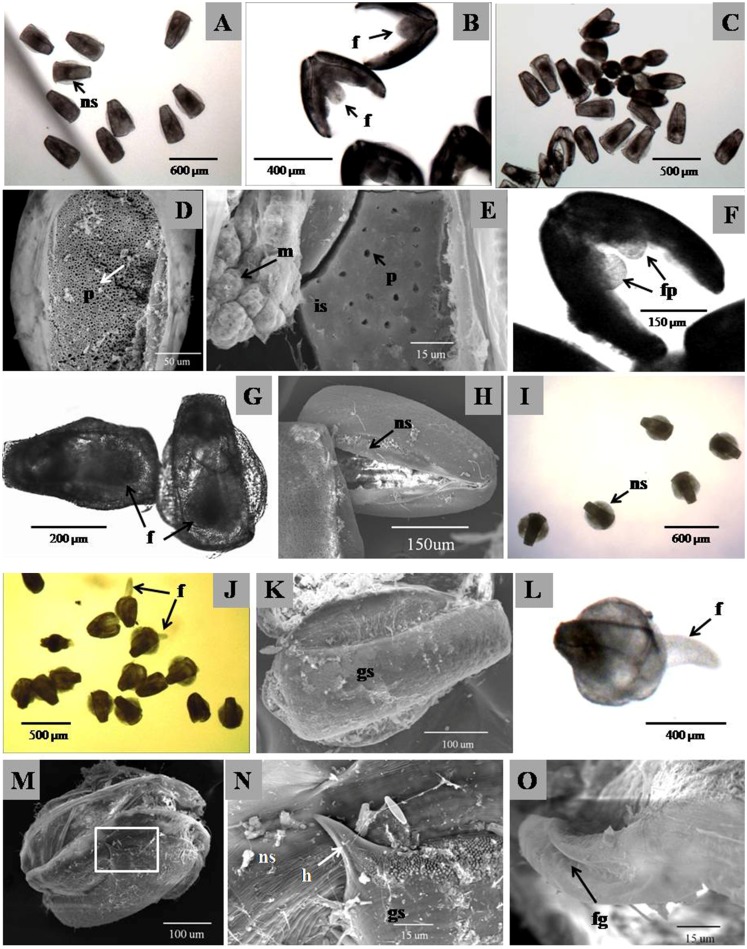
Morphological variation of glochidial metamorphosis in vitro culture with skewband grunt plasma.ns, new shell; gs, glochidial shell; is, interior of surface of shell; f, foot; fp, foot prototype; fg, foot groove; h, hook; m, mushroom cell; p, pit.